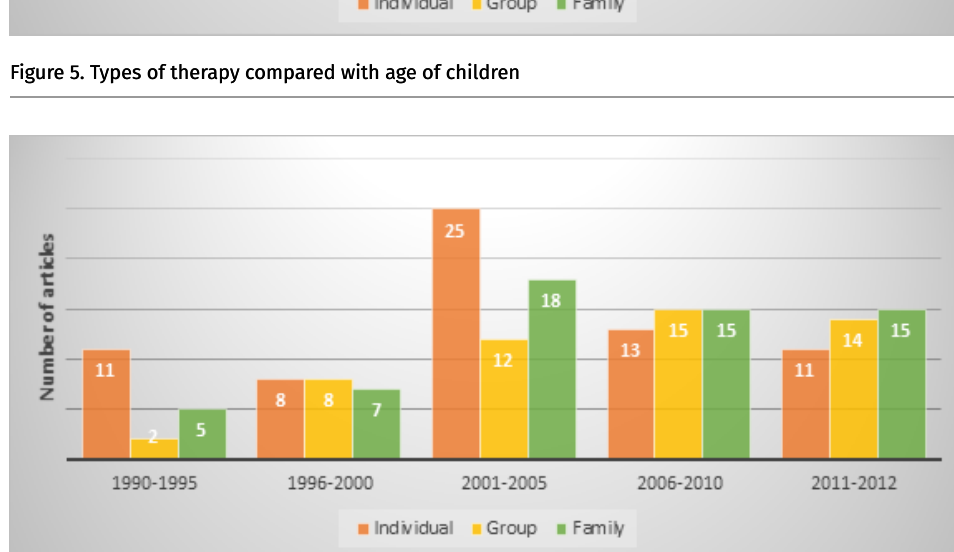
FFigigururee 66.. HistHistoricoricaall perperspectivspectiveses andand thertherapapyy